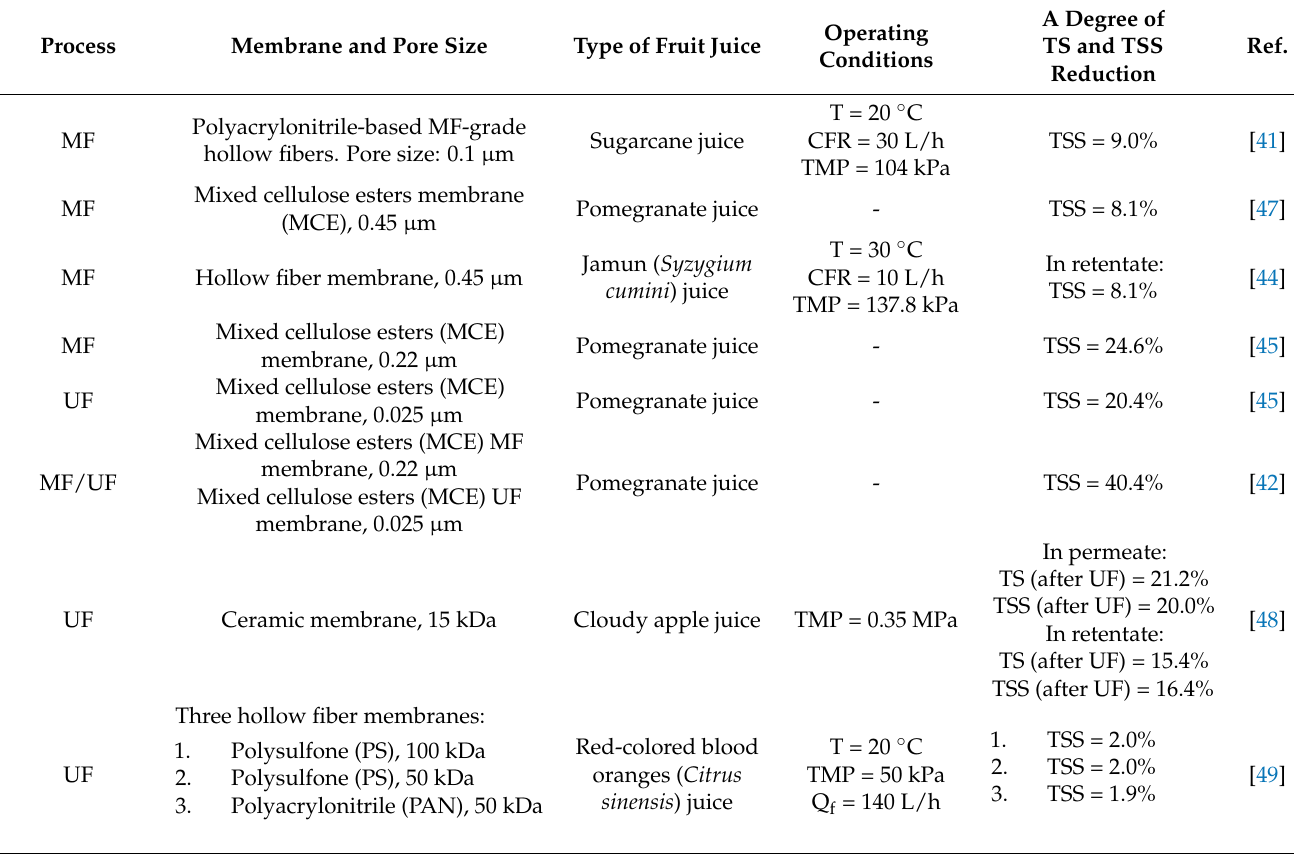
Table 2. Comparison of membranes possibility of a reduction of sugar content in fruit